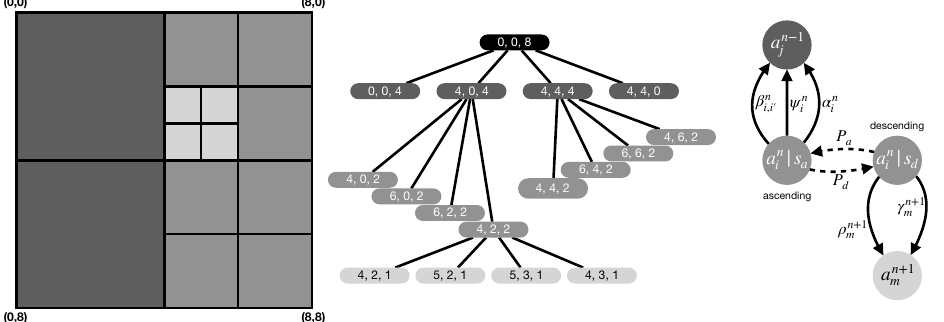
Figure 2. Left : Graphical representation of the considered hierarchical model. In this figure, the en- vironment is discretized in a 8 × 8 matrix (i.e., N = 8) and the corresponding quad-tree is built upon it, where only certain areas are partitioned, for the sake of brevity. Center : The quad-tree has a ( N ) = 3. Each node of the quadtree contains the identifying tuple ( x , y , l ) , maximum depth of log 2 with the x and y coordinates and size l of the corresponding area. For instance, a robot residing in area ( 4,2,2 ) has the possibility to descend to any of the four corresponding leaf-nodes, such as the cell ( 5,3,1 ) , exploiting its current knowledge of the sub-tree, or to ascend the quad-tree to area ( 4,0,4 ) for wider exploration of the environment. Right : probabilistic transitions between possible states, where a robot committed to a n can either move up to the parent node (area a n − 1 ) when in the ascending state i j s a , or move down to one of the children nodes (area a n + 1 m ) when in the descending state s d . Robots first decide whether to switch state s a → s d ( s d → s a ) with probability P d ( P a ). Then, transitions can take place that allow a robot to move in the quad-tree, either spontaneous (commitment γ n + 1 m , abandonment α n ) or interactive (recruitment ρ n + 1 m , cross-inhibition β n and self-inhibition ψ n i i , i (cid:48) i